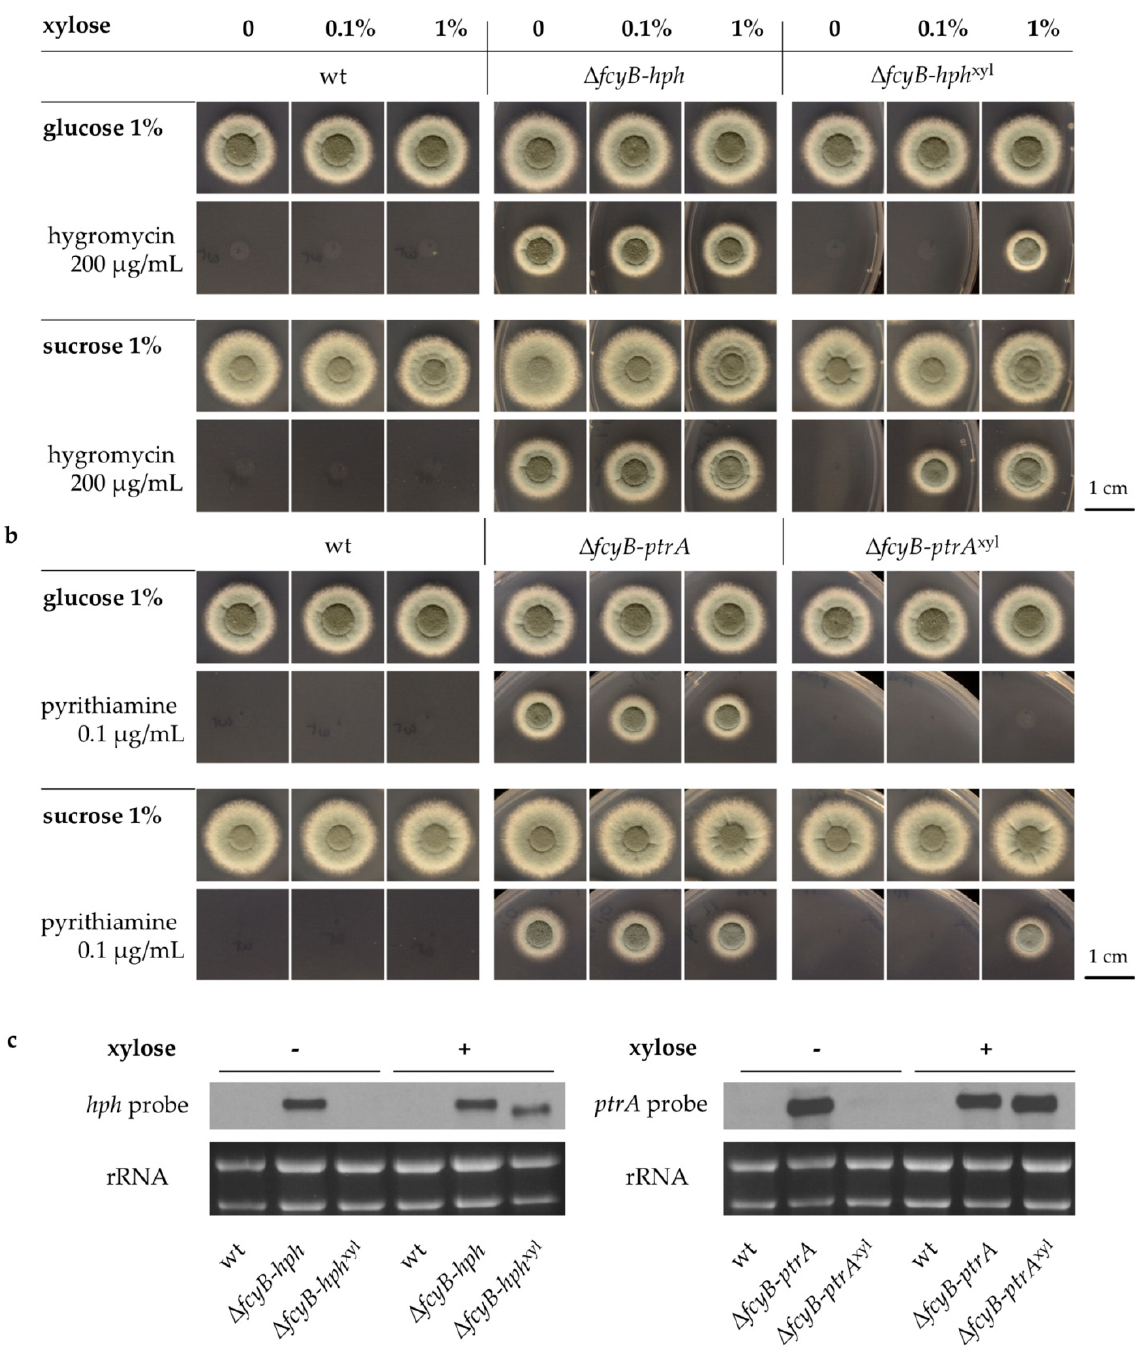
Figure 3. Characterization of inducible marker strains in comparison to their respective non-inducible version in the presence of different xylose concentrations. ( a ) Representative images of a hygromycin susceptibility growth assay for wt, ∆ fcyB-hph , and ∆ fcyB-hph xyl in the presence of xylose concentrations of 0%, 0.1%, and 1%, with either glucose or sucrose as a carbon source. ( b ) Representative images of a pyrithiamine susceptibility growth assay for wt, ∆ fcyB-ptrA , and ∆ fcyB-ptrA xyl in the presence of xylose concentration of 0%, 0.1%, and 1%, with either glucose or sucrose as a carbon source. ( c ) Northern blot analysis showing a comparison of the transcript levels of hph ( left ) and ptrA ( right ) in wt and drug-resistant strains in their non-inducible or inducible versions upon induction with 1% xylose and sucrose as a carbon